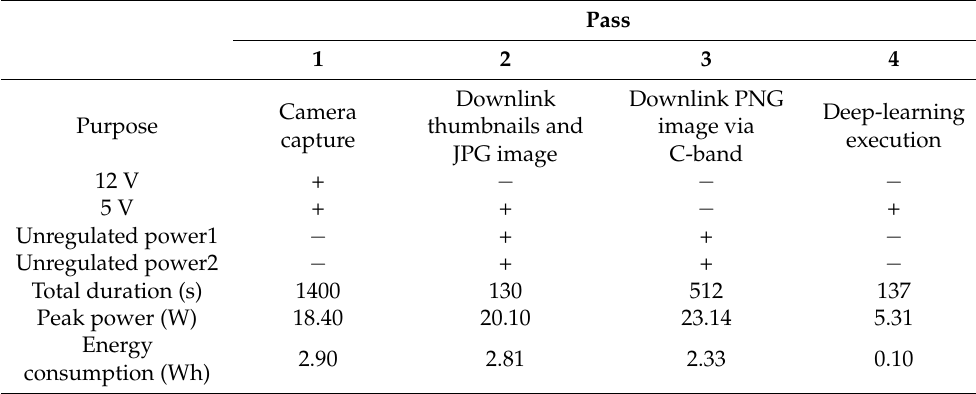
Table 2. Summary of mission execution in four passes during the long duration operation test (“+” means turn on and “ − ” means turn